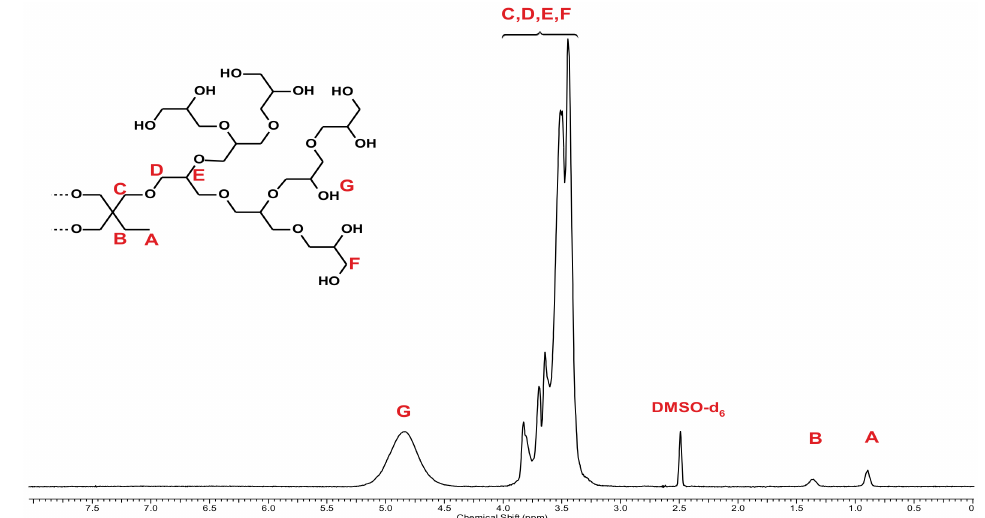
Figure 1. 1H-NMR spectrum and schematic architecture of